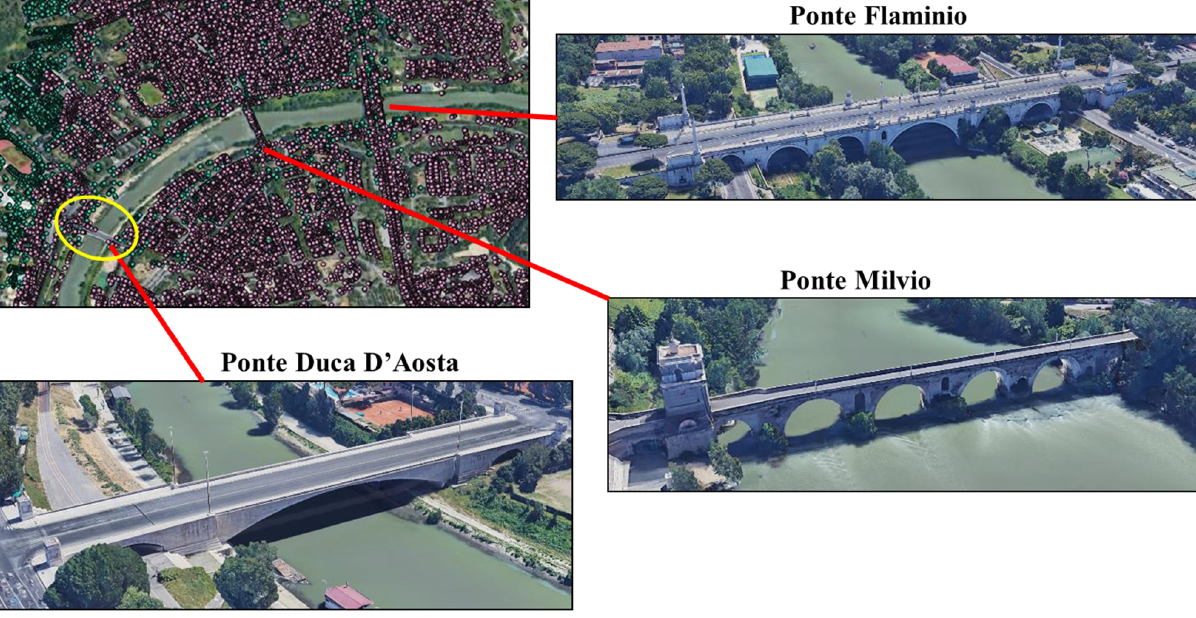
Figure 16. Measurement points detected by the satellite on the infrastructures located north of Ponte della